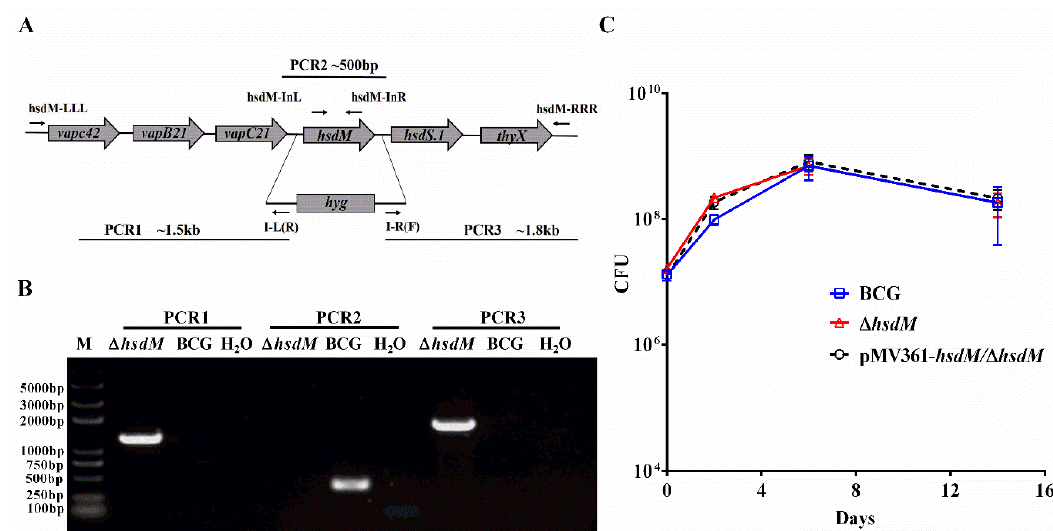
Figure 1. HsdM did not impact mycobacterial growth in vitro. ( A ) Genomic organization of the hsdM gene locus. Large arrows represent coding genes in their orientation. Small arrows represent the primer pair used for corresponding PCR. ( B ) PCR to confirm the knockout hsdM ( ∆ hsdM ) strains. The replacement gene, hygromycin-coding gene ( hyg ), is also shown. The PCR products of the upstream (PCR1) and downstream (PCR3) regions of hsdM using the primers pairs LLL/I-L(R) and I-R(F)/RRR, respectively. The PCR product of the gene fragment in hsdM using primers hsdM-InL and hsdM-InR (PCR2). ( C ) Growth curves of BCG, ∆ hsdM and pMV361- hsdM / ∆ hsdM strains in 7H9 medium. Data presented the means ± standard deviations (SD) from three independent experiments.